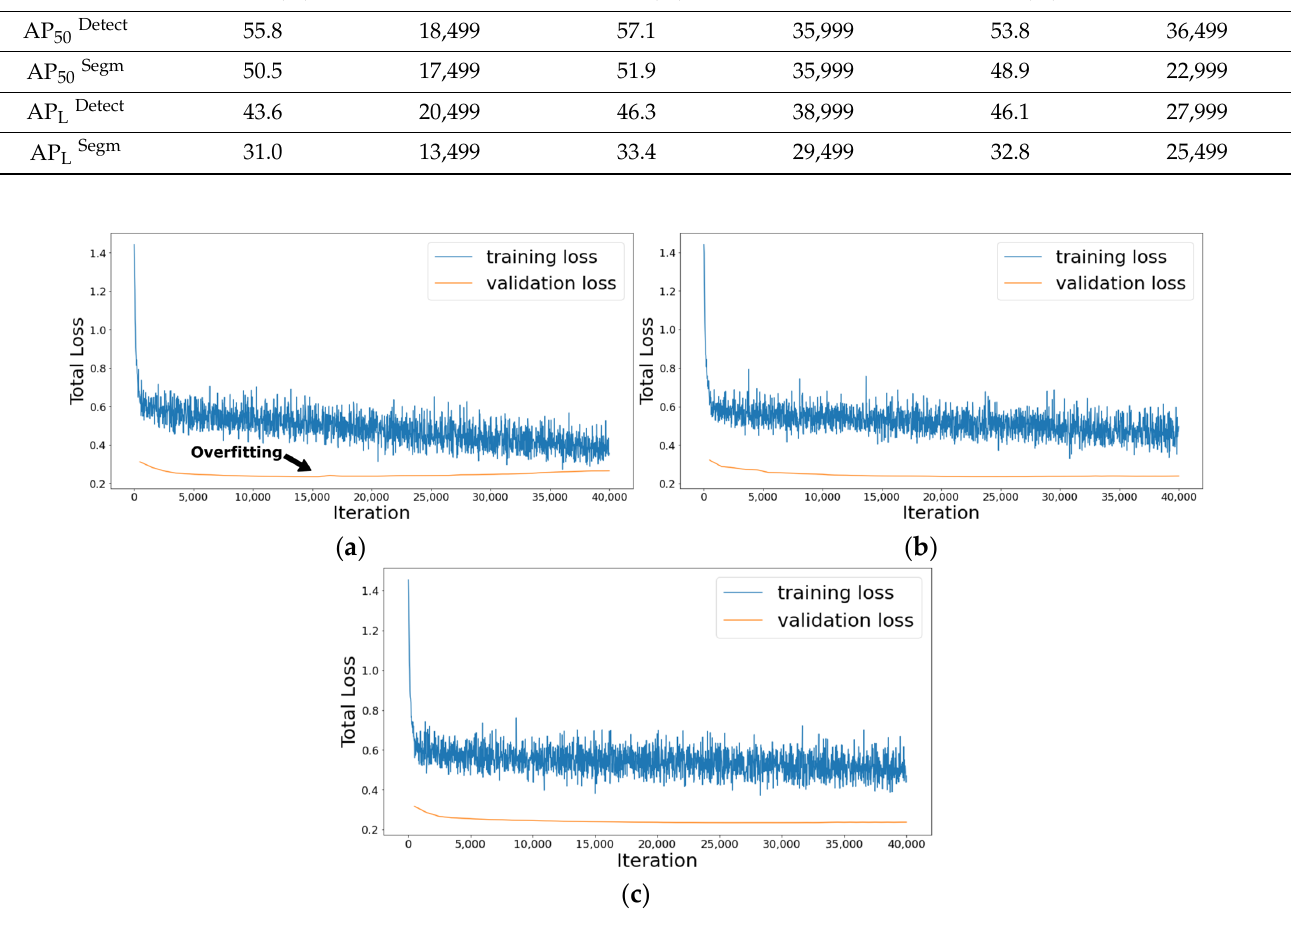
Figure 12. Training and validation curves for the loss function: ( a ) without DA, ( b ) moderate DA, and ( c ) intense